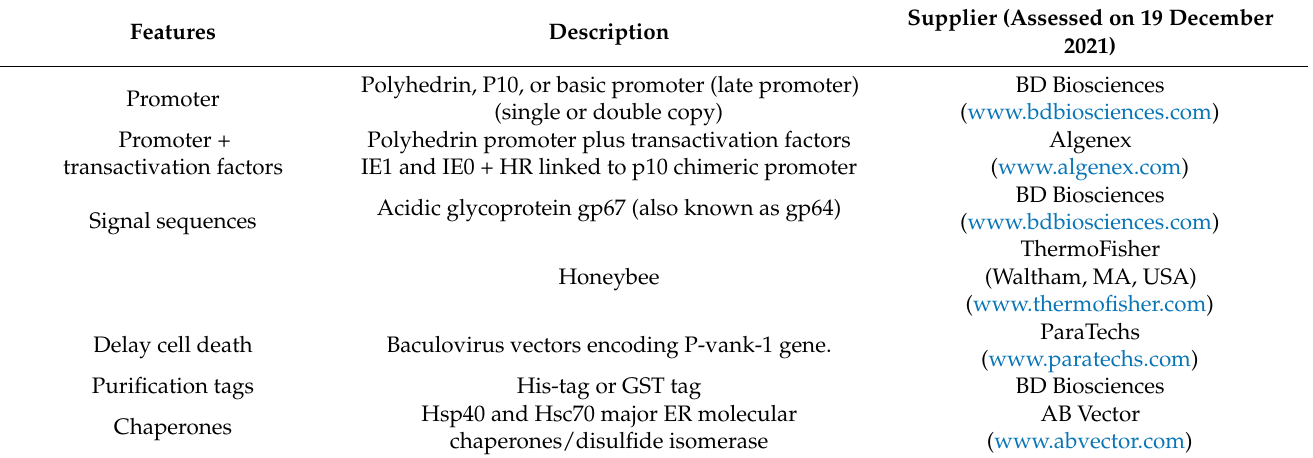
Table 1. Commercial transfer vector